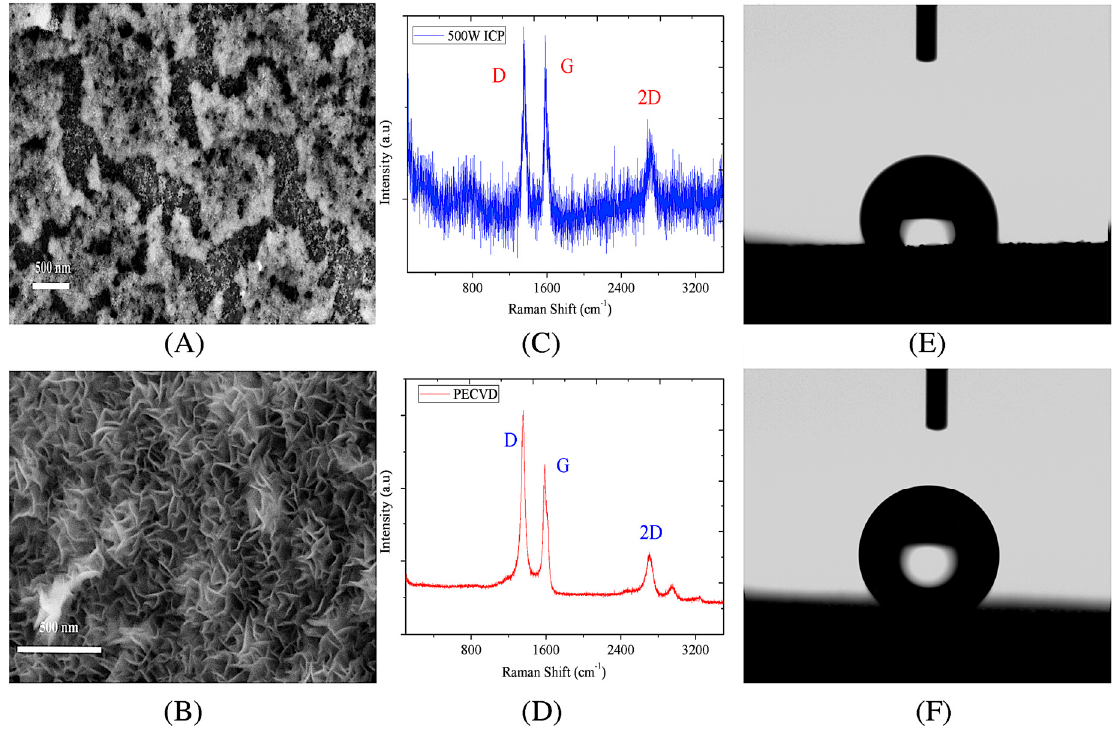
Figure 2. ( A ) High-resolution images; ( C ) Raman spectroscopy; ( E ) Contact angle of obtained carbon generated by ICP plasma; ( B ) High-resolution images; ( D ) Raman spectroscopy; ( F ) Contact angle of vertical graphene (VG) generated by PECVD. Power = 500 W, H 2 = 5 sccm, Ar = 20 sccm.